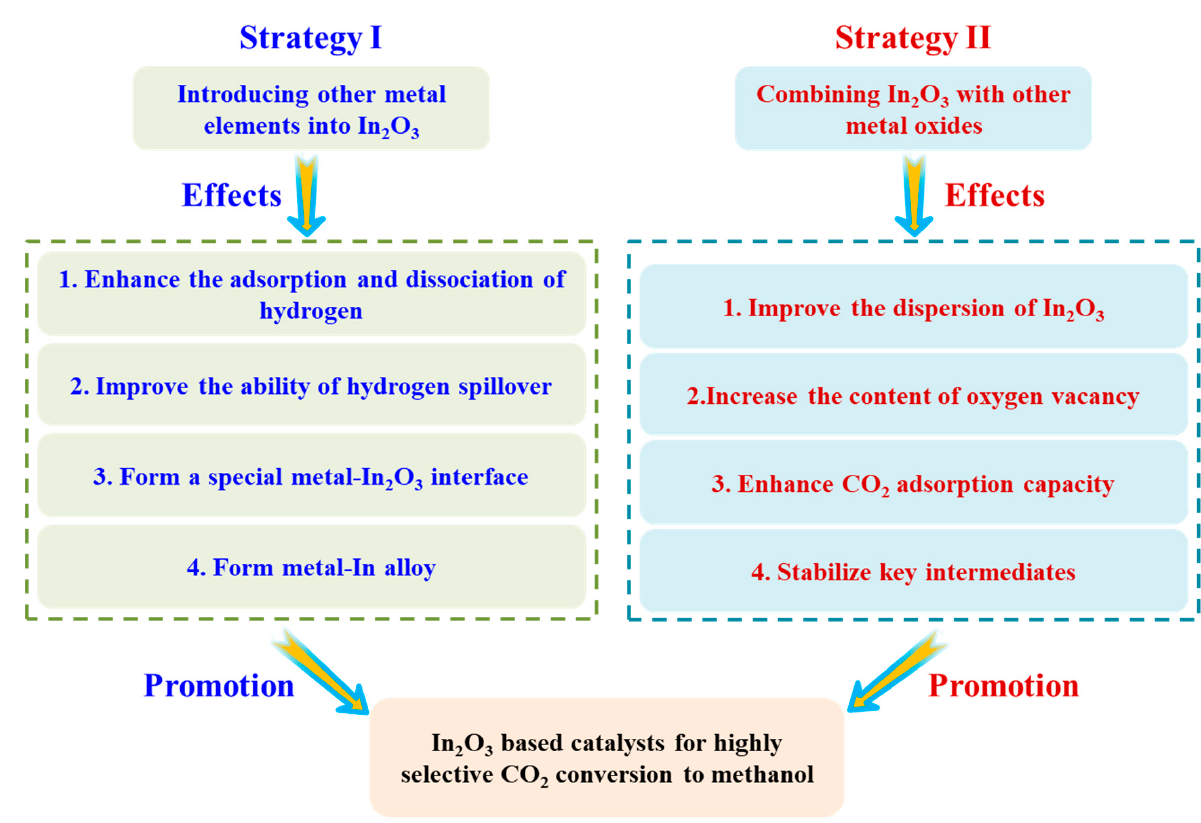
Figure 4. Two representative strategies for improving the performance of In 2 O 3 . Table 1. Catalytic performance of In 2 O 3 -based catalysts in previous study.